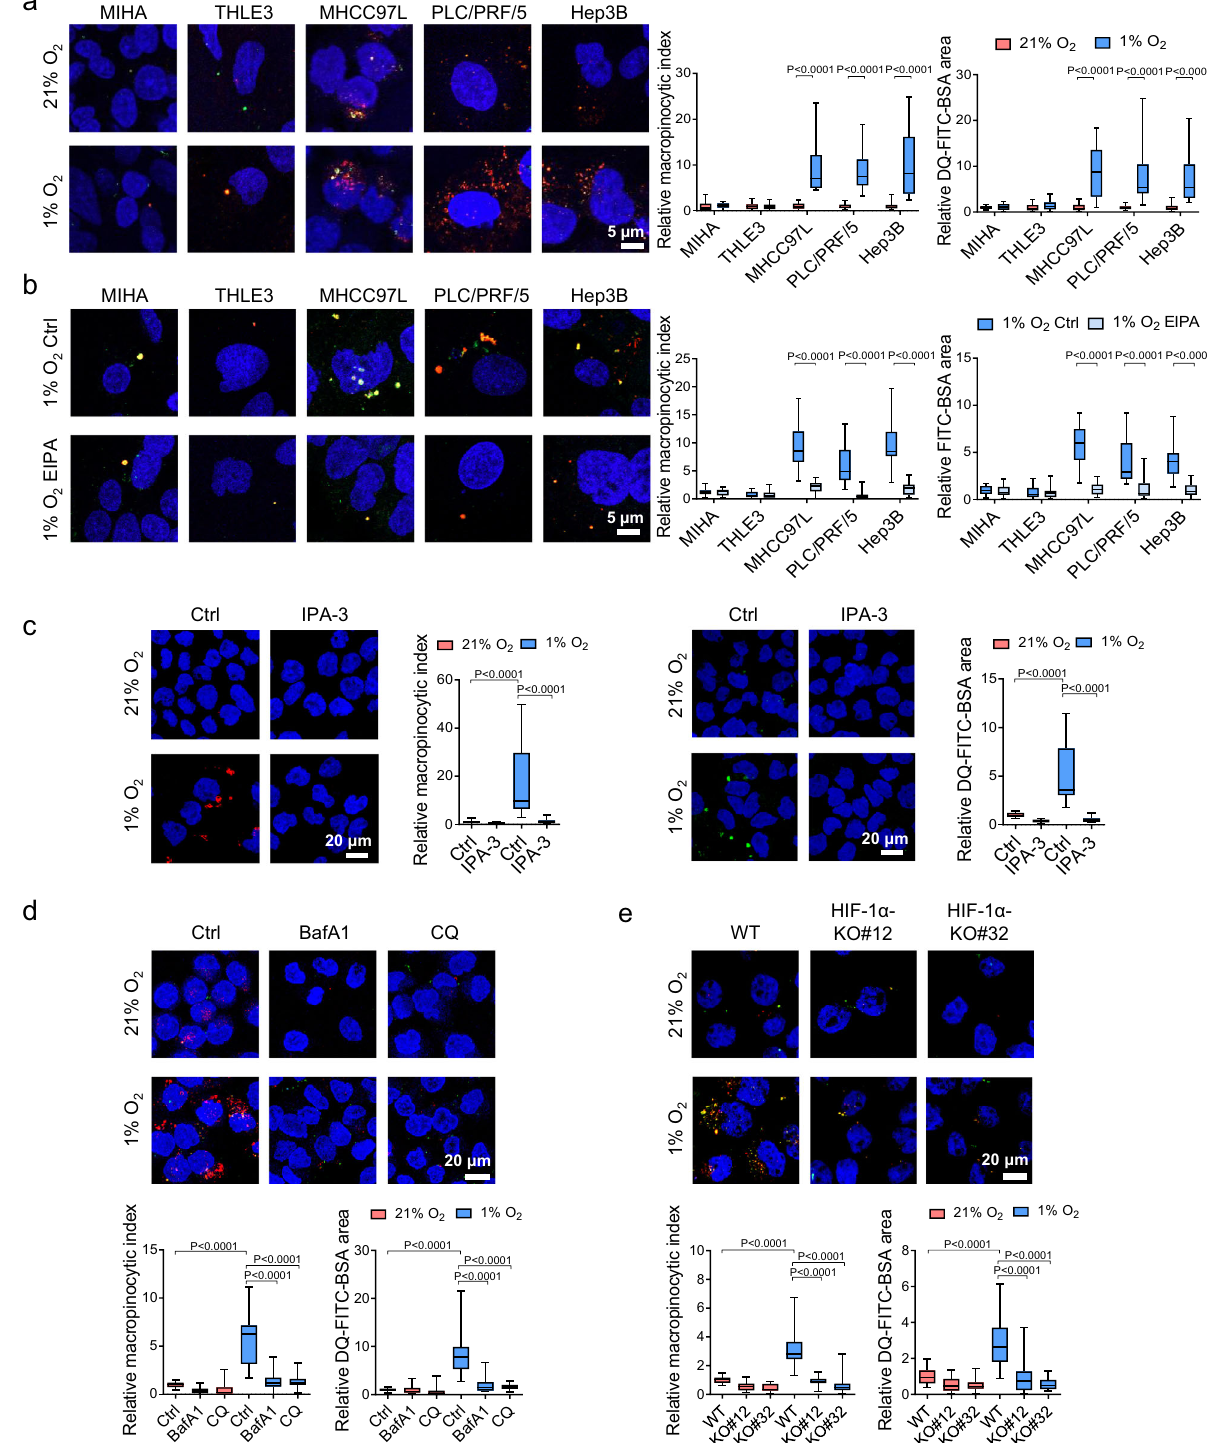
liver and HCC cell lines with dextran and constitutively fl uor- escent BSA, which can clearly indicate the internalization of BSA together with dextran. In all, 50 µM EIPA effectively blocked dextran and BSA uptake under hypoxic conditions, but has little effect on normoxic conditions that maintained a low level of macropinocytosis (Fig. 1b and Supplementary Fig. 1a). IPA-3 targets PAK1 to inhibit membrane ruf fl ing and the closure of NATURE COMMUNICATIONS| (2022) 13:954